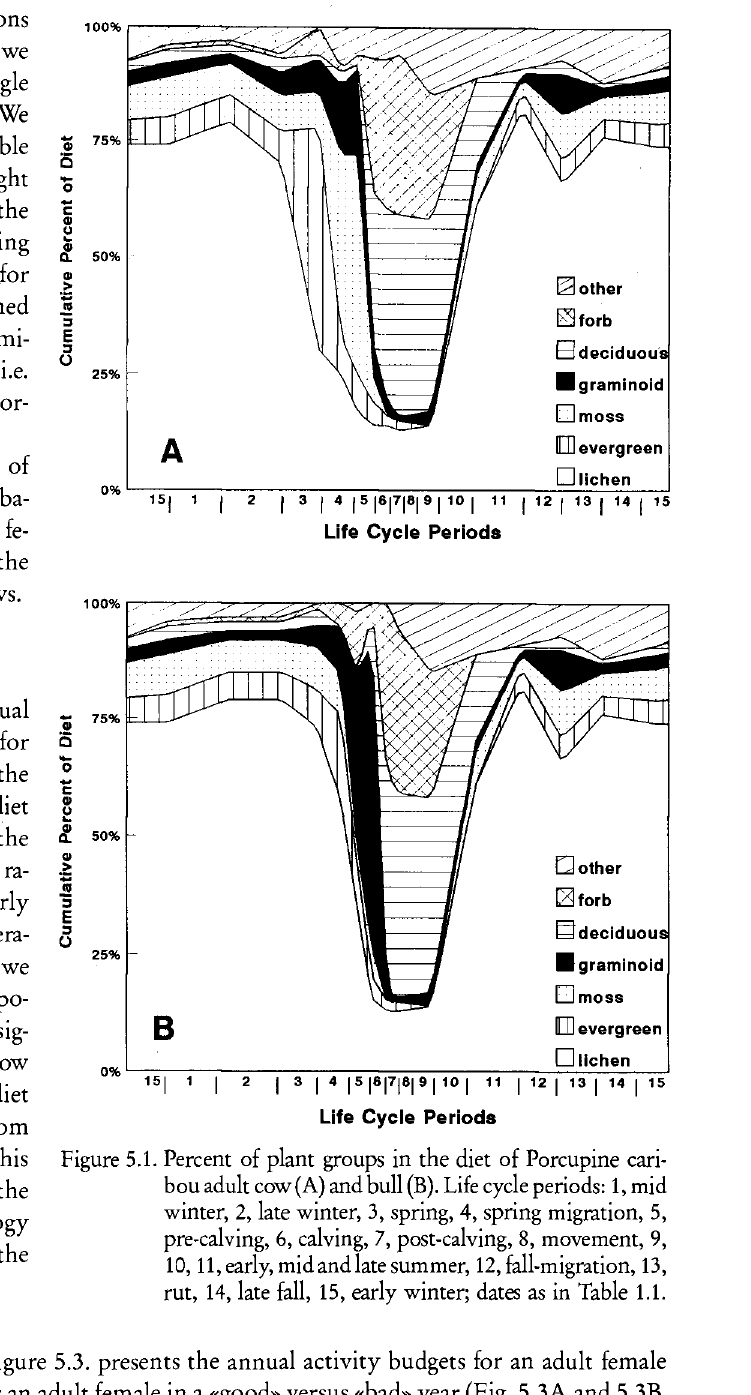
Figure 5.1. Percent of plant groups in the diet of Porcupine cari bou adult cow (A) and bull (B). Life cycle periods: 1, mid winter, 2, late winter, 3, spring, 4, spring migration, 5, pre-calving, 6, calving, 7, post-calving, 8, movement, 9, 10,11, early, mid and late summer, 12, fall-migration, 13, rut, 14, late fall, 15, early winter; dates as in Table